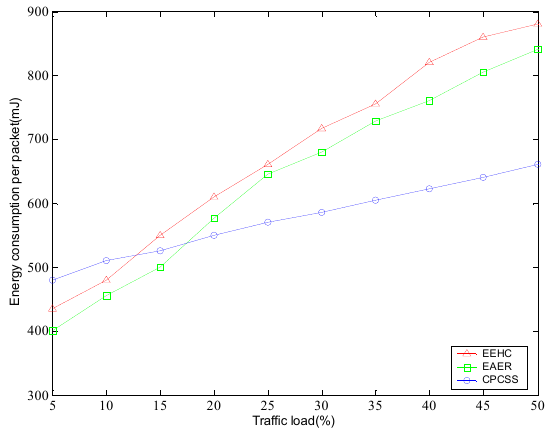
Figure 16. Energy consumption per packet in different traffic load.